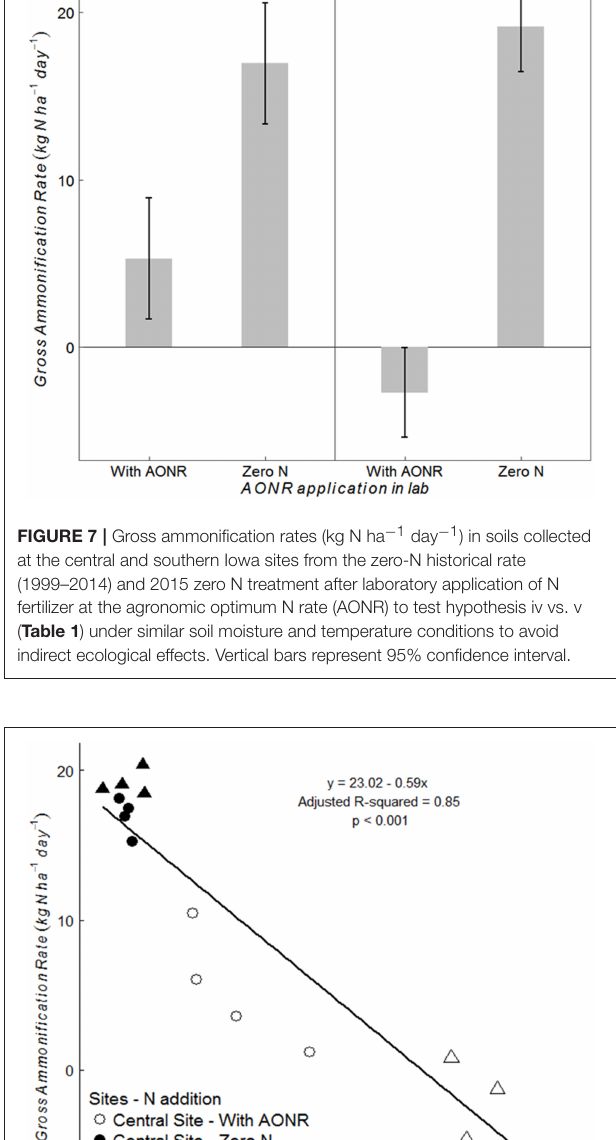
FIGURE 8 | Correlation between gross ammonification rate (kg N ha − 1 day − 1 ) and NH 4 -N (kg N ha − 1 ) pool size in soils collected from the 1999–2015 zero-N rate subplots, without laboratory fertilizer addition (closed symbol) and with laboratory N fertilizer addition at agronomic optimum rate (AONR) (open symbol) at central (circle symbol) and southern (triangle symbol) Iowa sites.